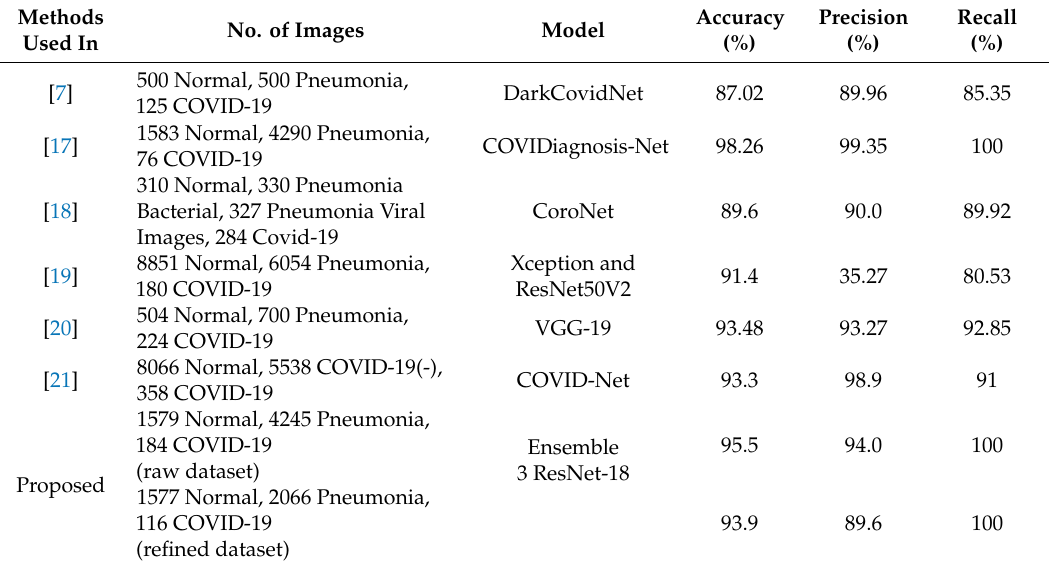
Table 4. Classification performance (Accuracy, Precession, and Recall) of proposed and existing methods used for 3 class